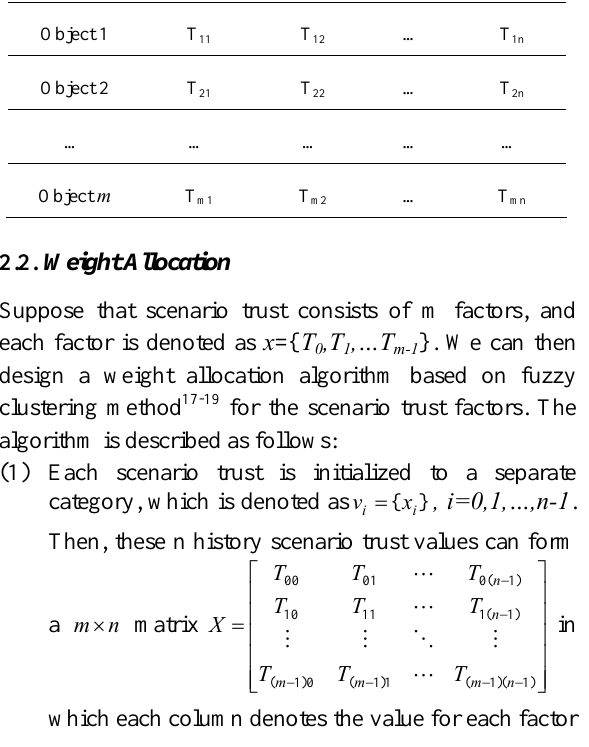
table and the subject accesses object i , then the trust value of risk control factor is: